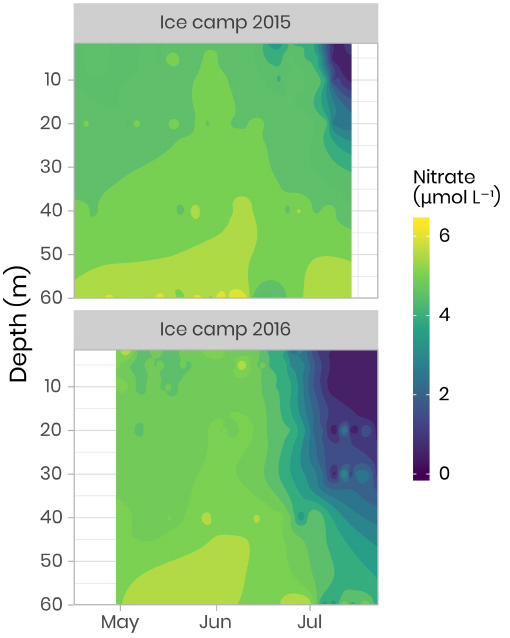
Figure 8. Temporal evolution of nitrate concentrations in the first 60m of the water column for both ice camp missions.